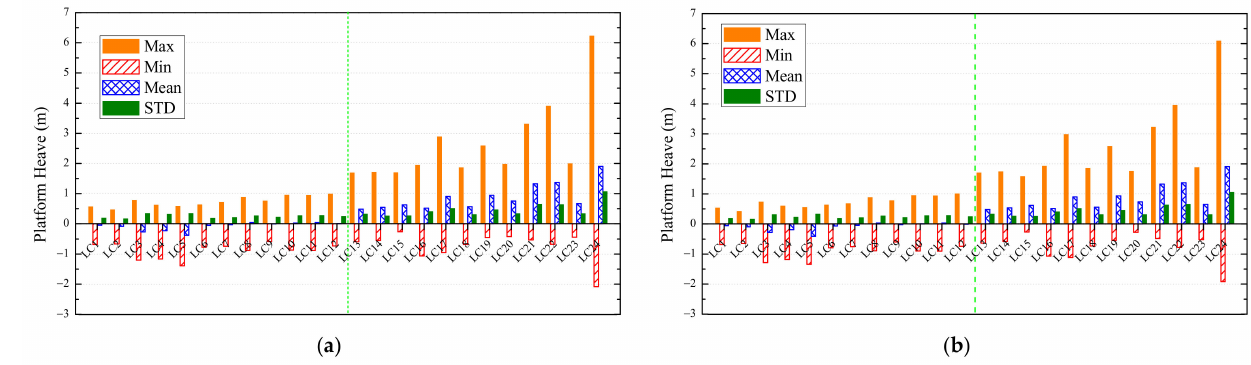
Figure 13. Statistics of platform heave motion response for ( a ) without current; ( b ) with